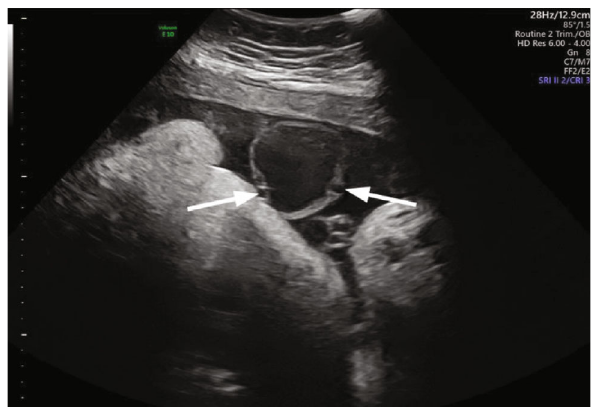
Figure 1: Cross-sectional view of the umbilical vein aneurysm with arrows pointing towards the umbilical arteries on either side.